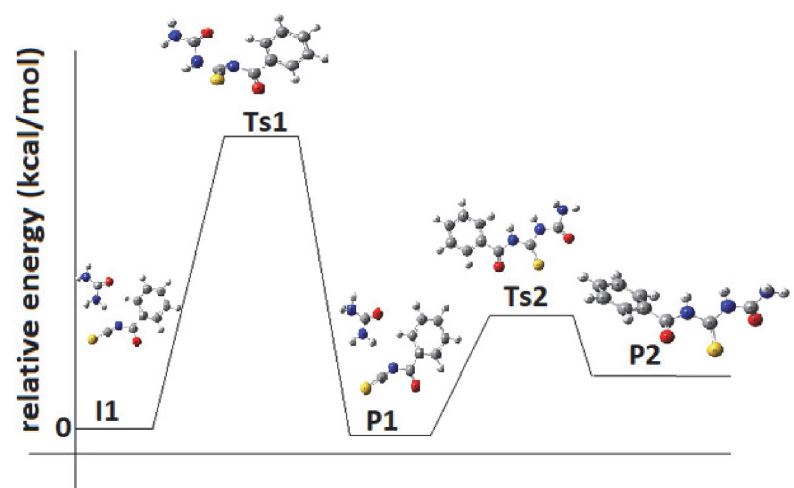
Figure 1 . The potential energy surface of the formation of N -(carbomylcarbamothioyl) benzamide computed using the B3LYP/6-31g(d) level of